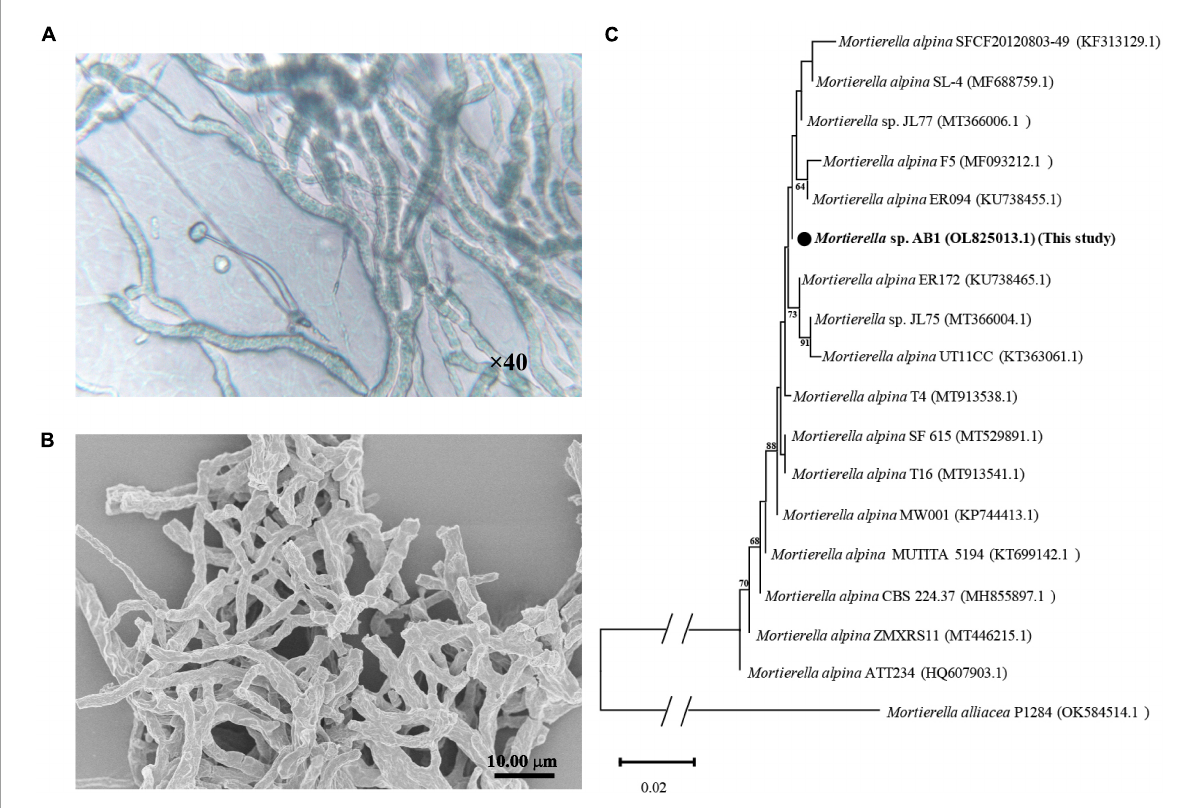
FIGURE1 Morphological and phylogenetic analysis of Mortierella sp. AB1. (A) Images captured under a light microscope under 40 × magnification. (B) Images captured under a scanning electron microscope. (C) Phylogenetic tree inferred from the Neighbor-Joining (NJ) analysis based on the ITS1-ITS4 sequence of strain Mortierella sp. AB1.